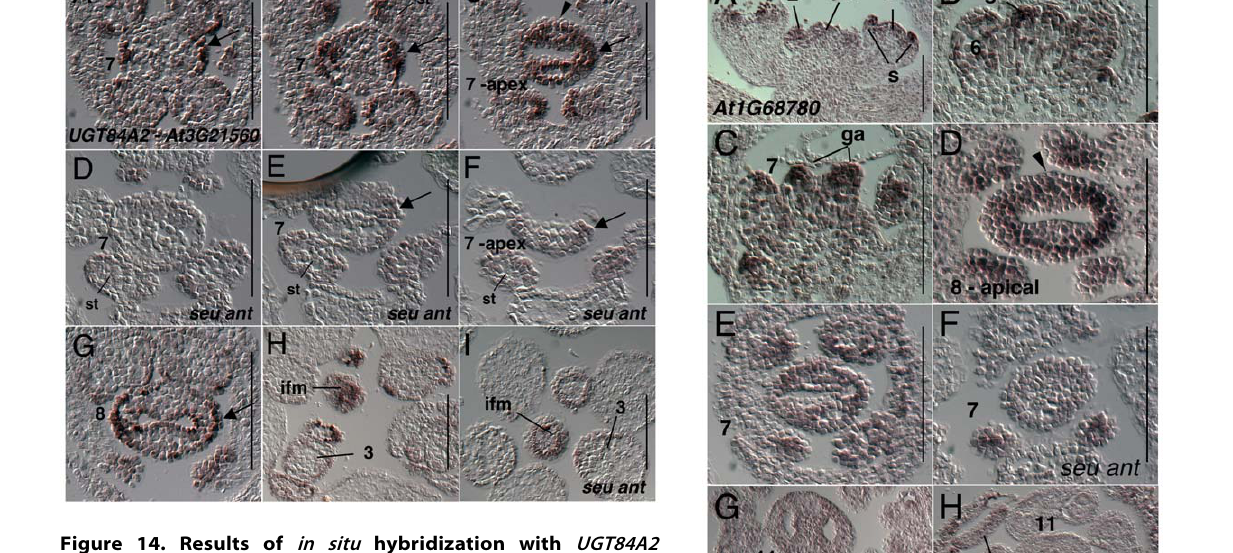
Figure 14. Results of in situ hybridization with UGT84A2 (At3G21560) antisense probe. Panels A, B, and C as well as panels D, E and F are consecutive serial sections. The section in panel A was located 16 microns basal to the section in panel C and section in panel D was 16 microns basal to the section in panel F. Numbers indicate floral stages. All panels show transverse (cross sectional) tissue orientation. Scale bars are 100 microns in all panels. Arrowheads indicate medial domain expression. Arrows indicate valve domain expression. All panels are Col-0 wild type tissue unless otherwise marked. ifm - inflorescence meristem.